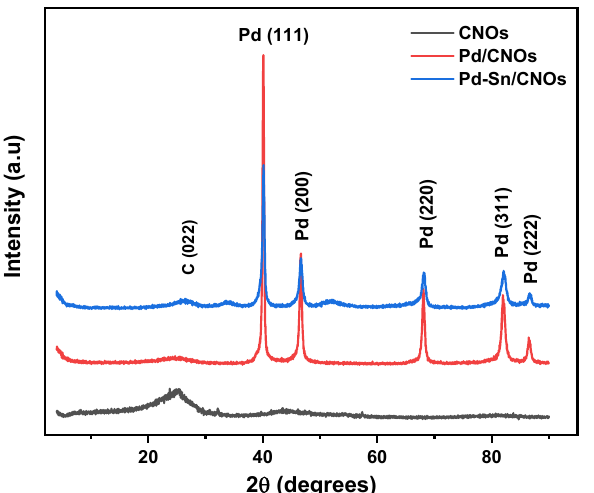
Figure 5. XRD patterns of carbon nano-onion (CNO) supports and Pd/CNO and Pd-Sn/CNO electro- catalysts.